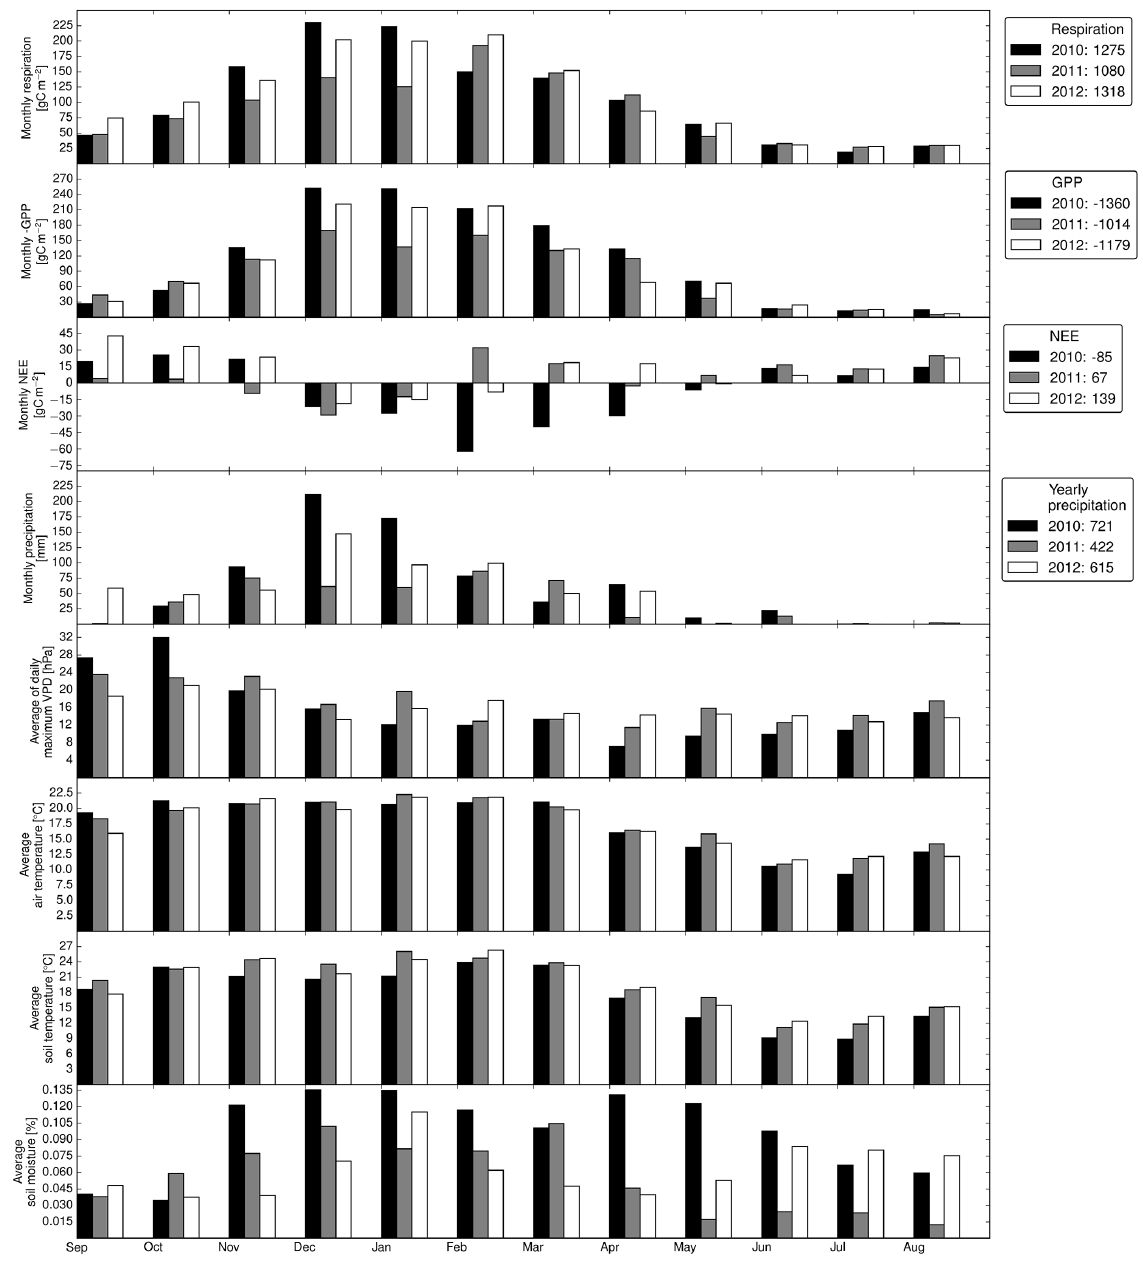
Figure 8. Monthly sums of respiration, GPP, NEE, and precipitation and the monthly average of air temperature, soil temperature, soil moisture and daily maximum VPD. The panels on the right side show the yearly sums for the years 2010–2011, 2011–2012 and